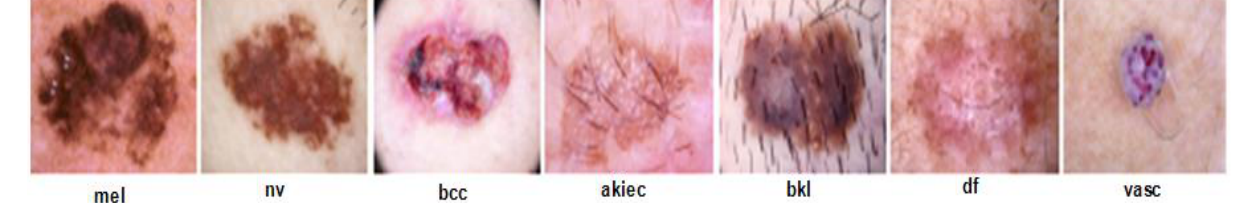
Figure 1. Sample images of HAM1000 dataset. melanoma (mel), melanocytic nevus (nv), basal cell carcinoma (bcc), actinic keratosis intraepithelial carcinoma (akiec), benign keratosis (bkl), dermatofibroma (df), and vascular lesion (vasc).